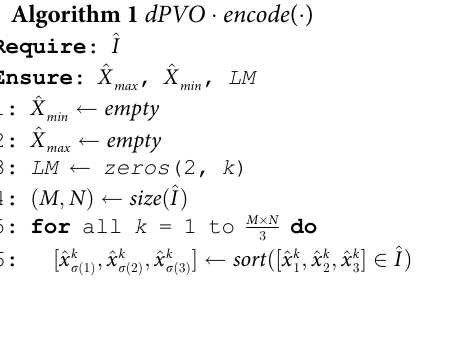
Algorithm 1 dPVO � encode ( �